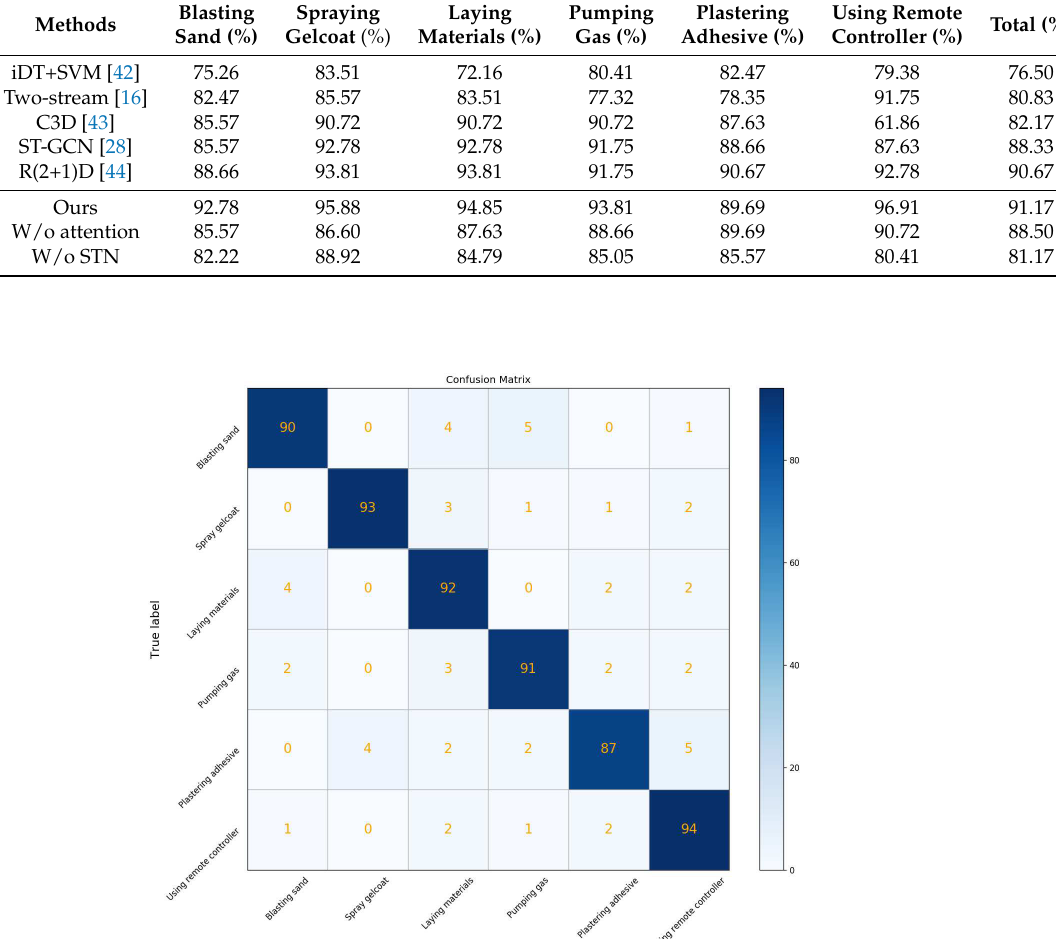
Table 4. Comparison of our methods and existing methods on test data.